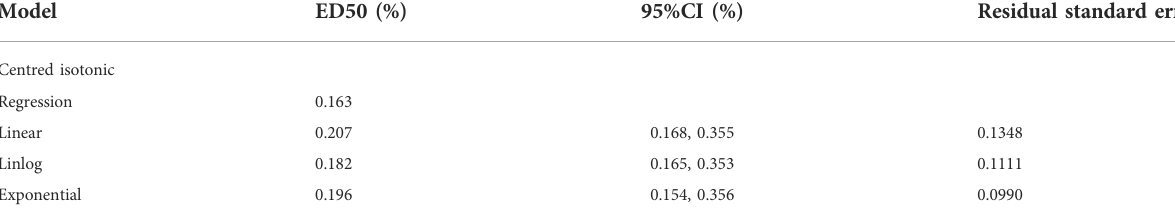
TABLE 2 The mean effective concentration and 95% con fi dence interval of the different models.